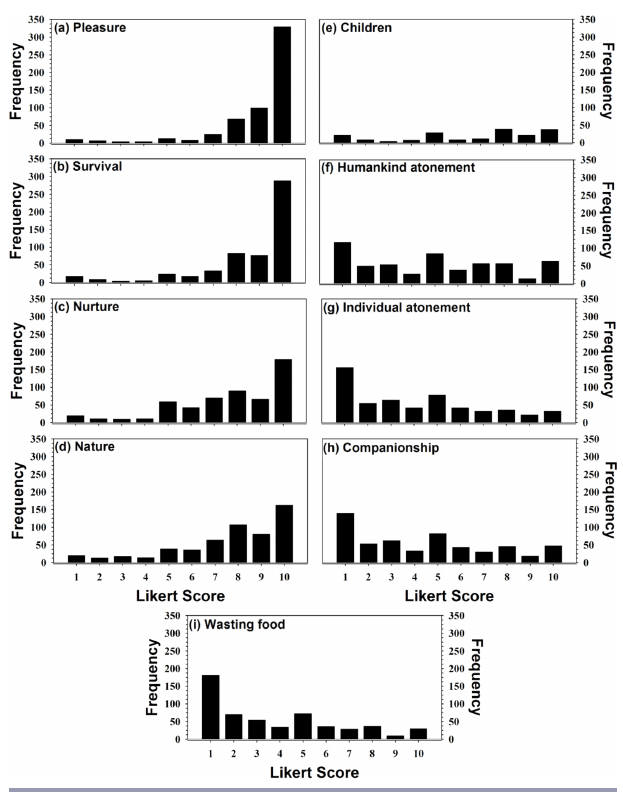
Fig. 1 . Frequency distributions of respondent scores on a Likert scale of 1 to 10 (where 1 = strongly disagree and 10 = strongly agree) when asked about the importance of various motivational themes (a) to (i) in their bird feeding participation in south-east England in